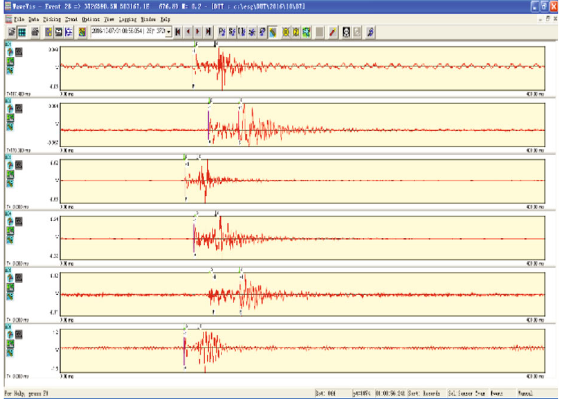
Figure 30: Microseismic event waveform.